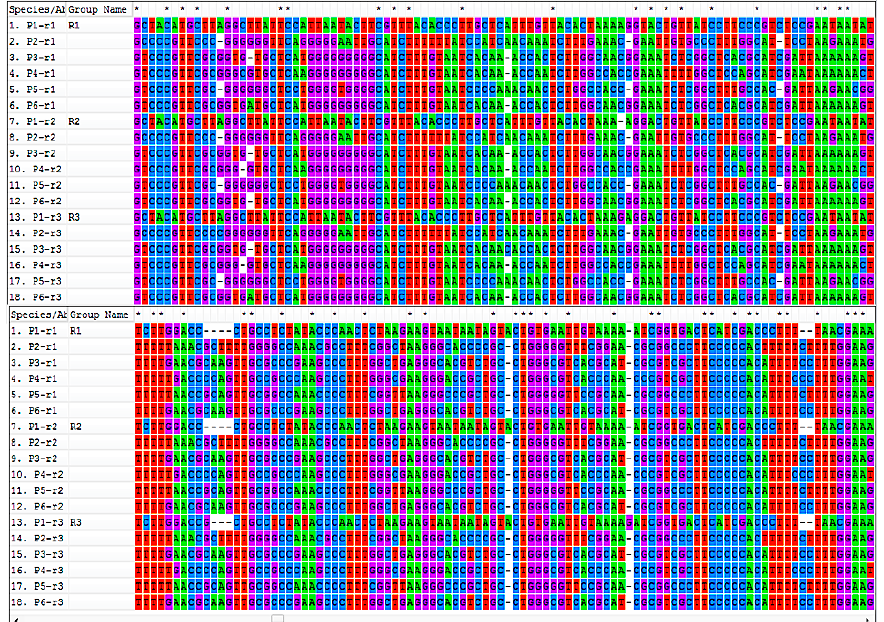
Figure 4. ITS sequencing of the three replicates (r1 to r3) of each six seed lots (P1 to P6) of Conyza spp. P1 ( C. bonariensis ) = Tal-al-Ramel site, P2 ( C. canadensis ) and P3 ( C. bonariensis ) = University of Jordan Research Station site, P4 ( C. bonariensis ) and P5 ( C. canadensis ) = al-Twal site and P6 ( C. bonariensis ) = University of Jordan Campus site. A, C, G and T are DNA nucleotides. * refers to identical nucelotides with same color.